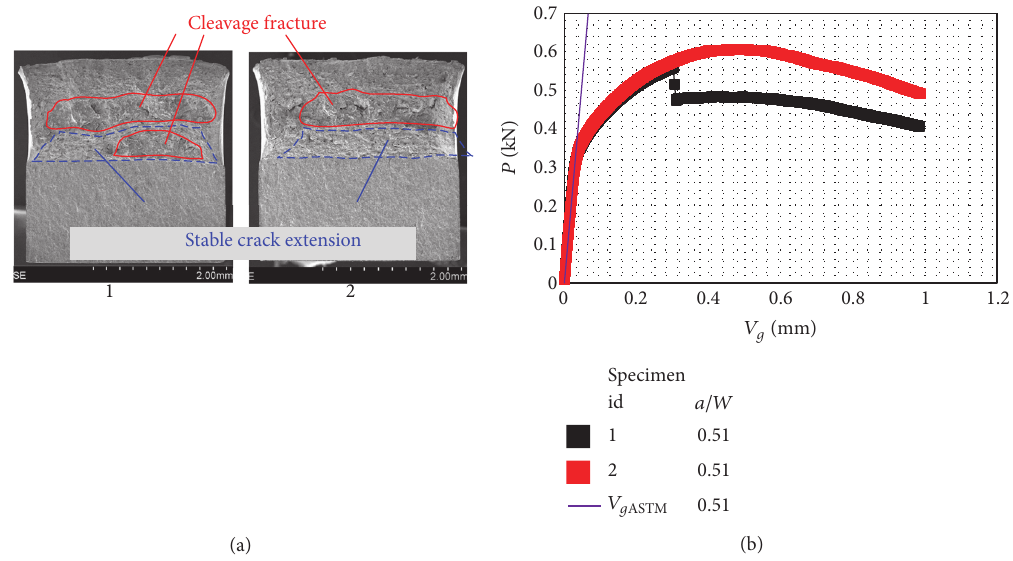
Figure 12: Fracture surfaces and load 𝑃 versus crack-mouth opening displacement 𝑉 𝑔 diagrams of the 3t SE(B) specimens (S55C, 20 ∘ C). Pop-in correlated with cleavage mechanism was observed for specimen id 1. However, large stable crack extension before cleavage fracture was observed for specimen id 2, as predicted from the (4𝛿 𝑡 ,𝜎 22𝑐 ) failure criterion. Note that 𝑉 𝑔 = 1 mm does not correspond to the final